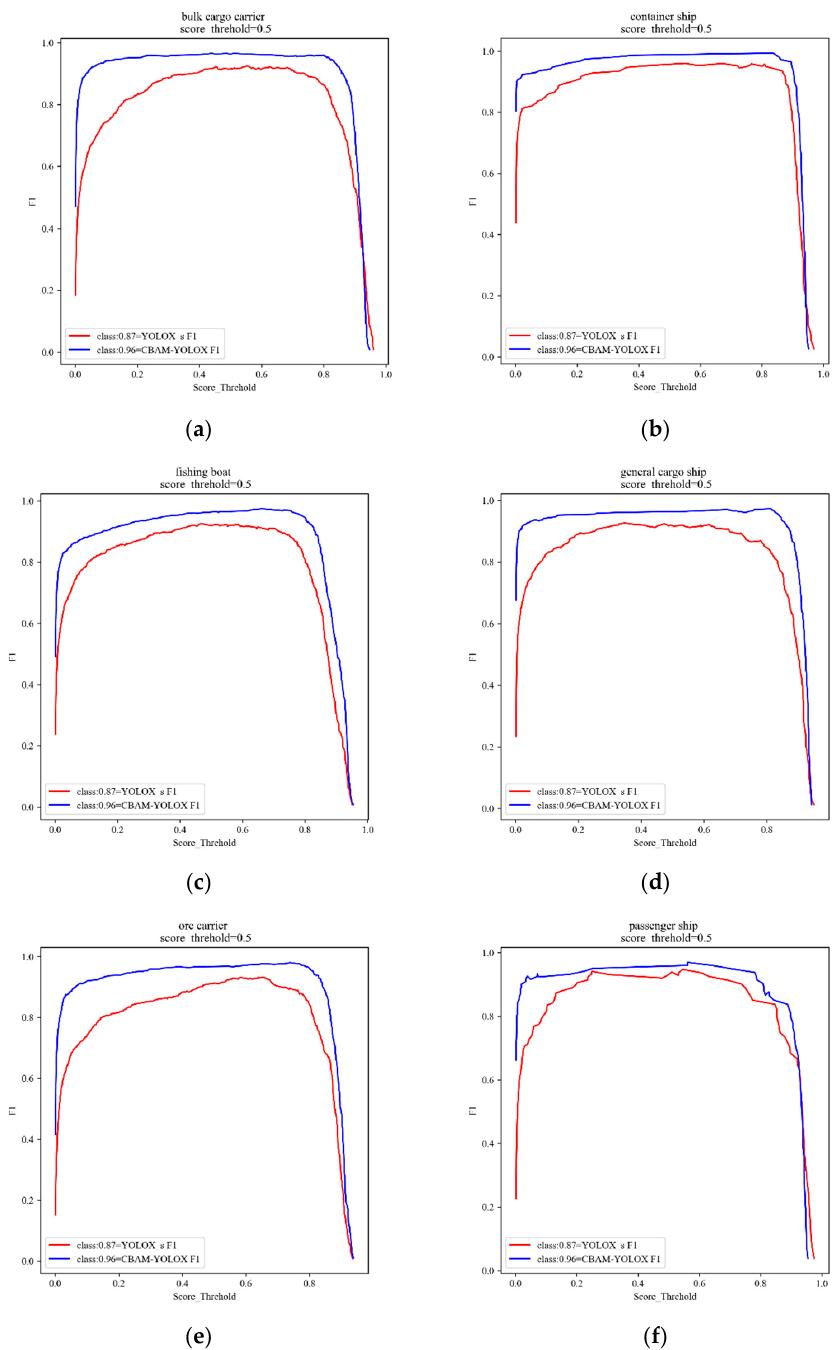
Figure 8. F1 curves of YOLOX_s network compared with CBAM-YOLOX network. ( a ) F1 curve for bulk cargo carrier; ( b ) F1 curve for container ship; ( c ) F1 curve for fishing boat; ( d ) F1 curve for general cargo ship; ( e ) F1 curve for ore carrier; ( f ) F1 curve for passenger ship.